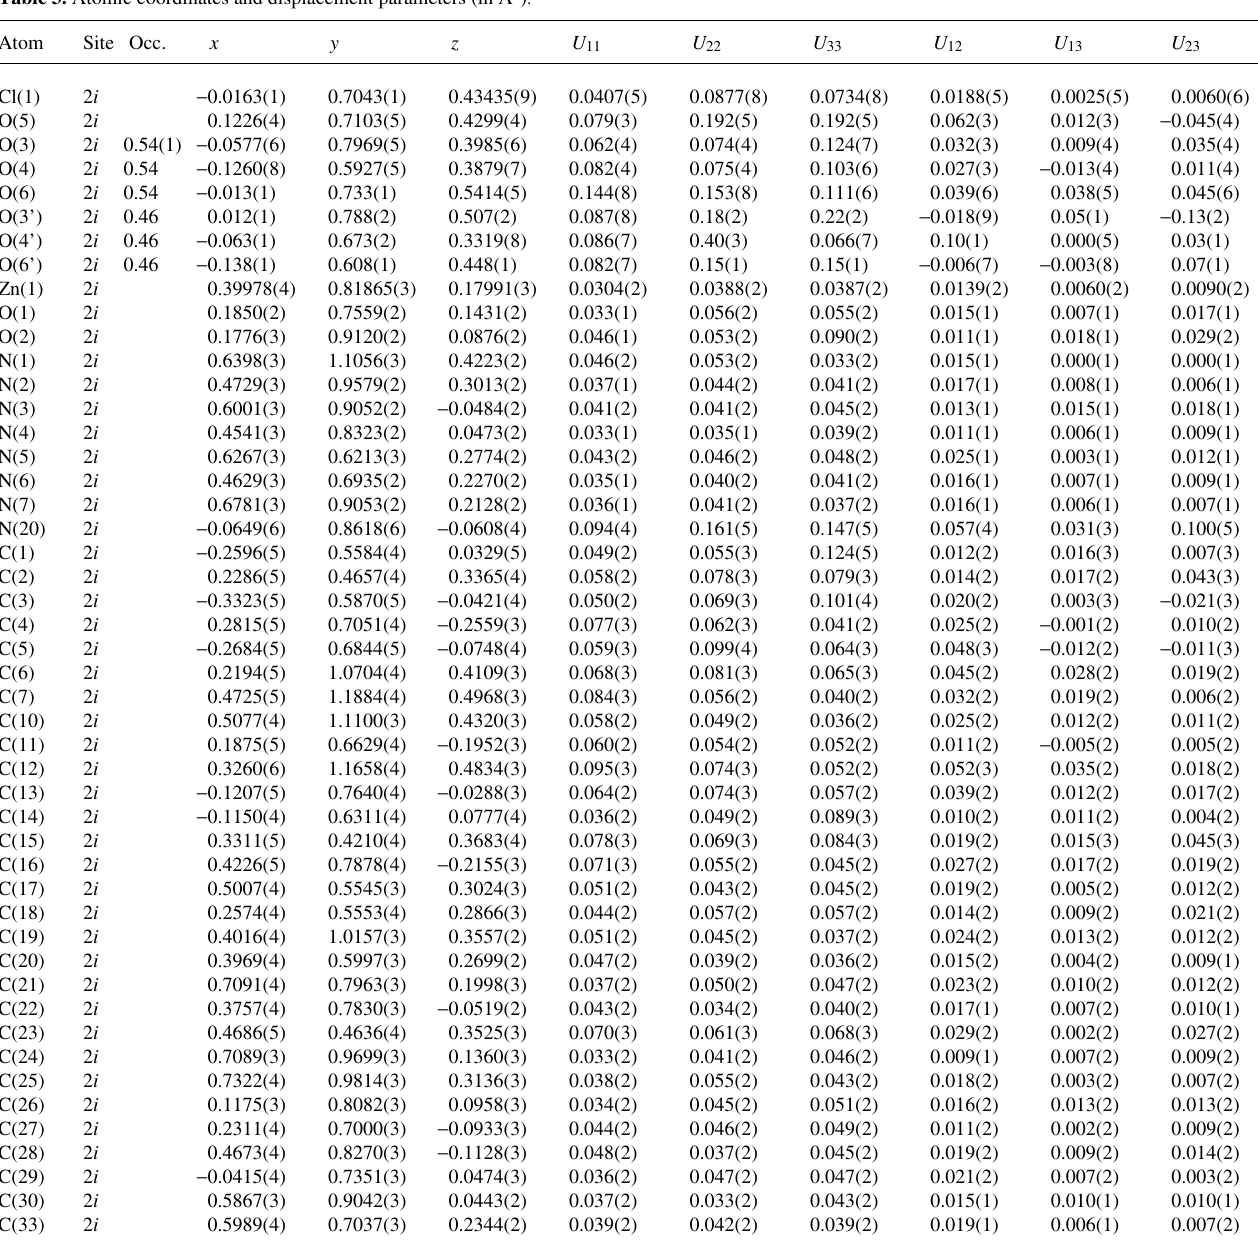
Table 3. Atomic coordinates and displacement parameters (in Å 2 ) .